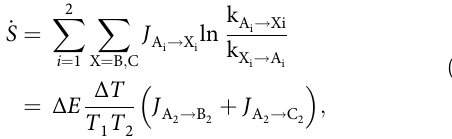
Fig. 1 Selection of states in a three-state two-box model. a A three-state chemical system diffusing in a temperature gradient, modeled as two connected boxes at different temperatures, T 1 = T m + Δ T /2 and T 2 = T m − Δ T /2. The states B and C have the same energy and the energy barrier between A and C , Δ ϵ C (cyan/light gray), is lower than the one between ( B 2 )) gauges the global non-equilibrium unbalance between B and C . Under non-equilibrium conditions, C is favored with respect to B , since it participates in faster reactions. Here, T m = 0.1, Δ E = 2, Δ ϵ C = 1 and d = d A = d B = d C , with k B set to 1. R CB is a monotonously increasing function of d , and the dashed lines indicate the limit for d → ∞ , computed in Eq. (4). c log R CB ones that remain fi xed are as in b . Black dashed lines indicate the approximate value of the optimal gradient in both cases, Eq. (7). As we can see, it provides a good estimate of the actual value, even for fi nite